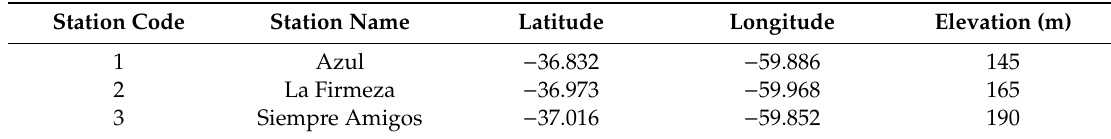
Table 2. Location of the meteorological stations used for the study.